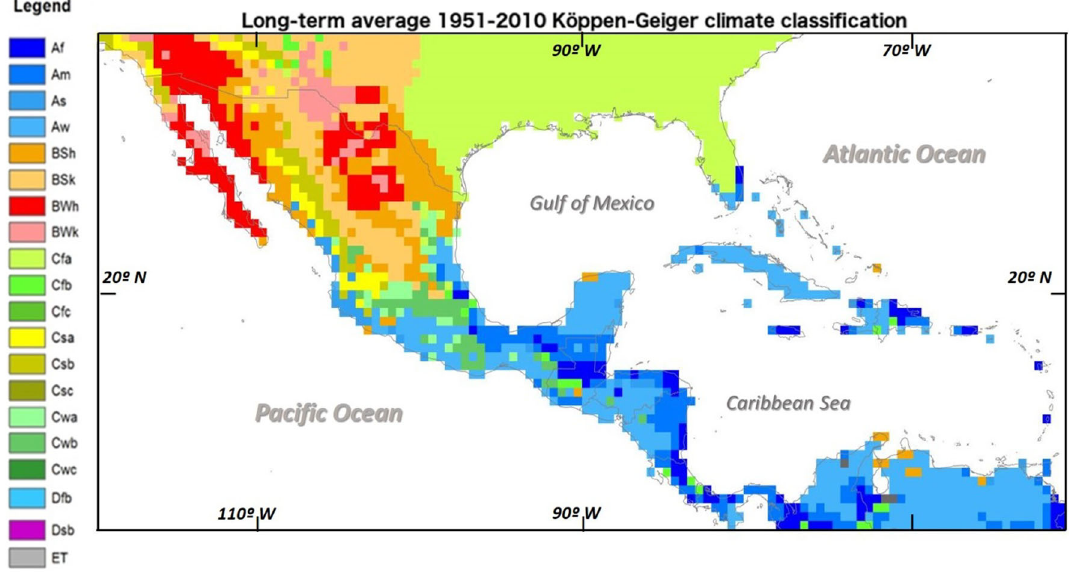
Fig. 1 Ko¨ppen–Geiger climate classification based on long-term average (1951–2010) climate data for the Central American and circum- Caribbean region. Source : Adapted from Chen and Chen